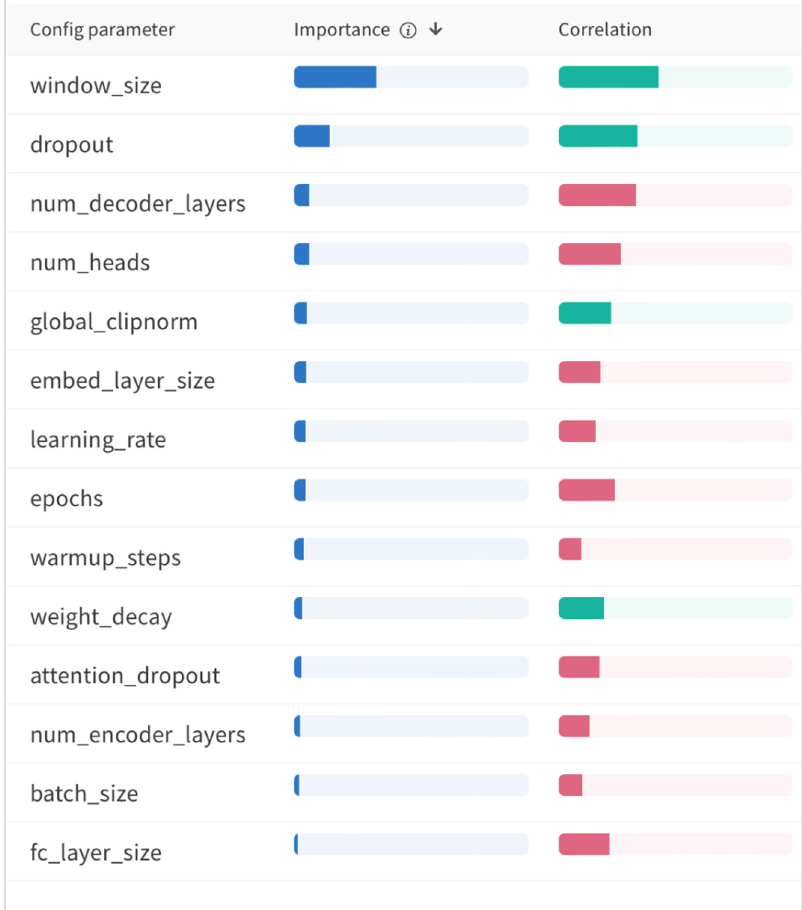
Figure 11. Significance of the hyperparameters and their correlation with the best validation mean squared error metric.